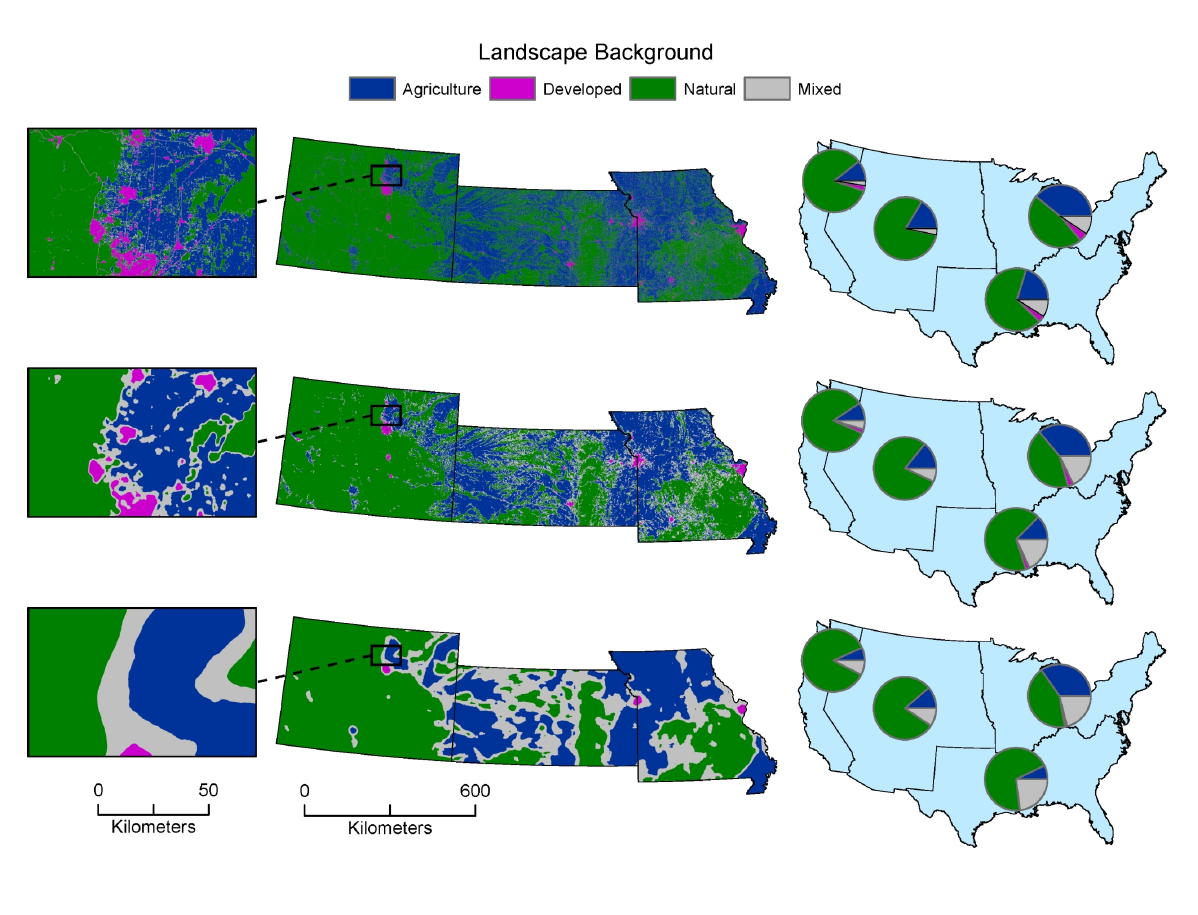
Figure 2: The landscape background describes the dominant land-cover in a landscape. Center: Landscape background exhibits both fine-scale and coarse-scale patterns in the States of Colorado, Kansas, and Missouri. The three landscape sizes shown are 4.4 ha (top row), 591 ha (middle row), and 47800 ha (bottom row). Left: Illustrations of spatial detail at each scale near the city of Denver. Right: the relative proportions of landscape backgrounds in each of four regions are shown by the pie